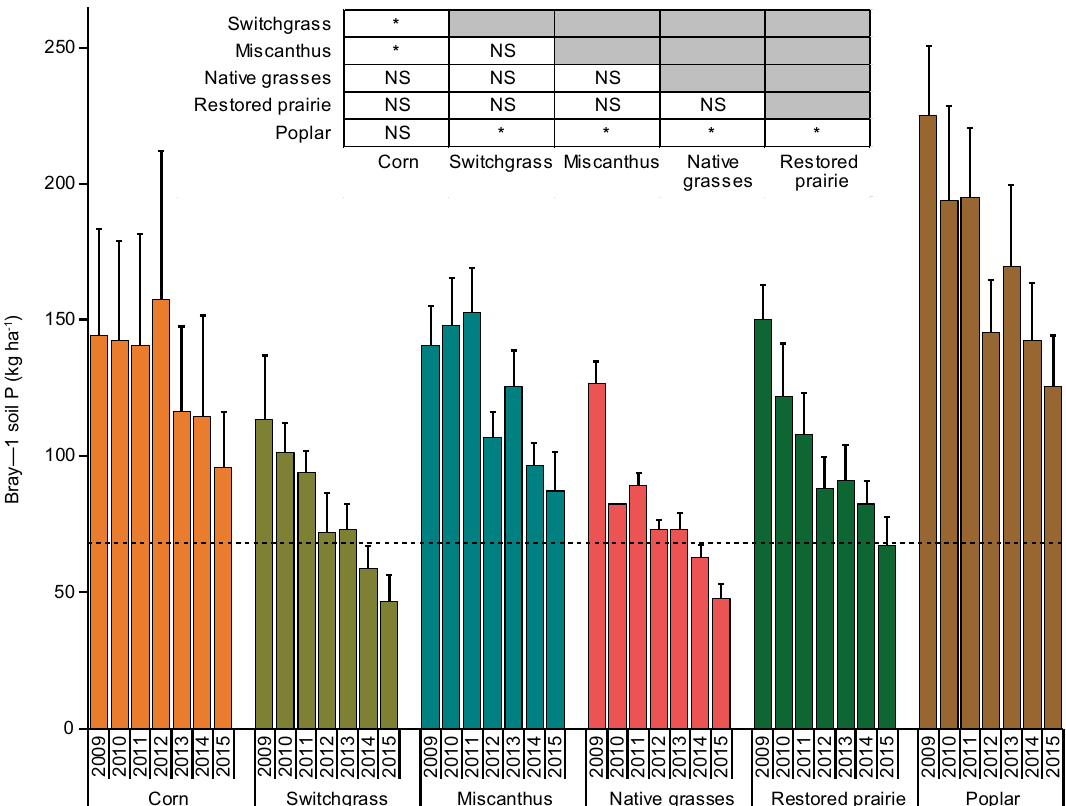
Figure 3. Bray-1 soil test phosphorus in the upper 25 cm of soil in the different cropping systems. Each bar shows the standard error of the mean of four replicate plots. The inset shows which system means grouped across years are significantly different (*) in pairwise comparisons as determined by the Tukey honest significant difference test (α = 0.05; NS = not significantly different). Bold dashed line indicates critical lower threshold of soil test phosphorus recommended for corn production (68 kg P ha −1 , equivalent to 15.0 mg kg −1 ).